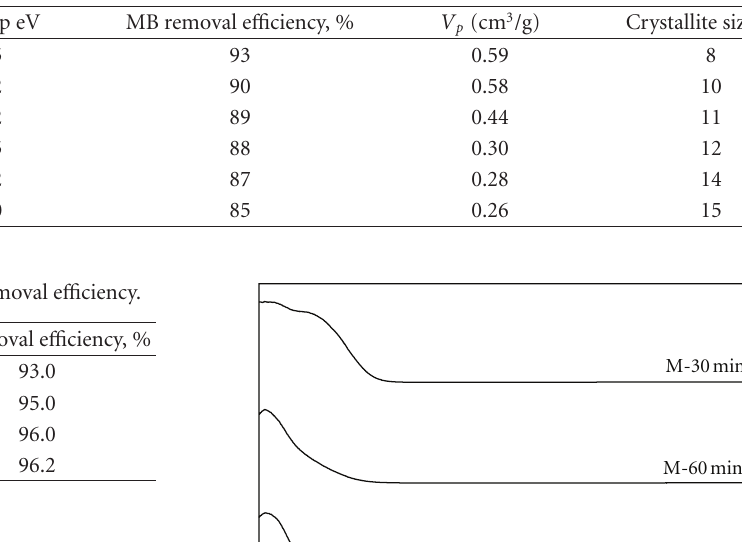
Table 4: E ff ect of CeO 2 -SiO 2 nanoparticles on the photoactivity.